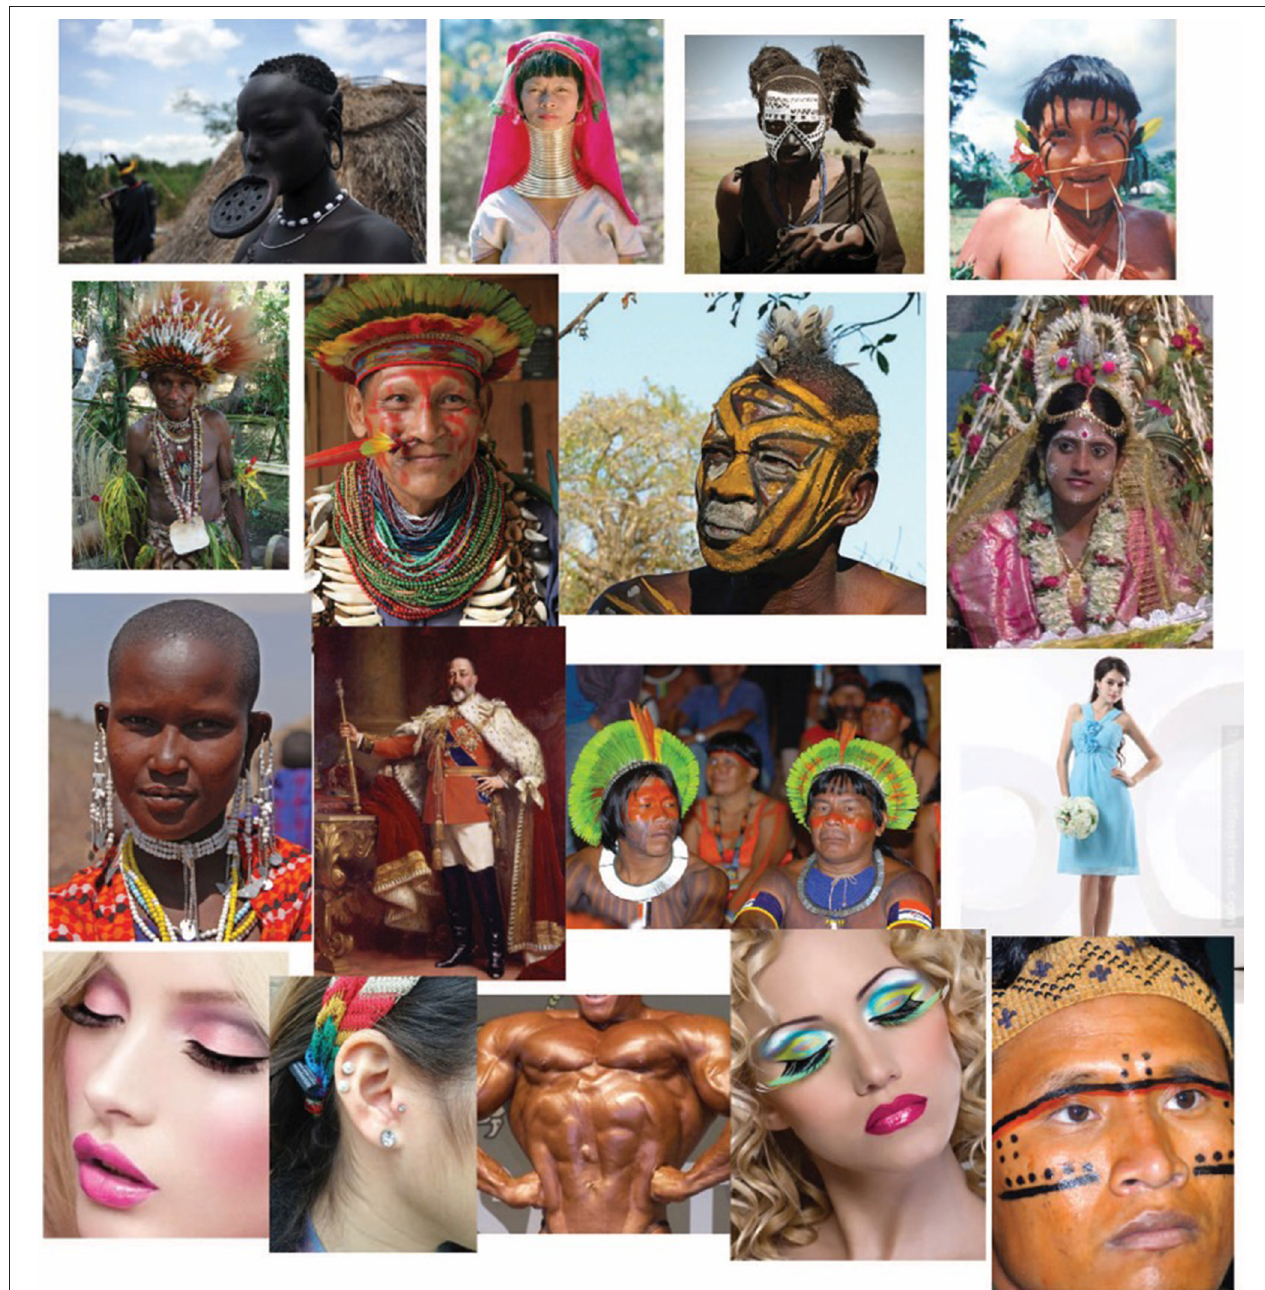
FIGURE 15 | The basic role of the principle of accentuation and coupling in different contexts and aspects of human life.